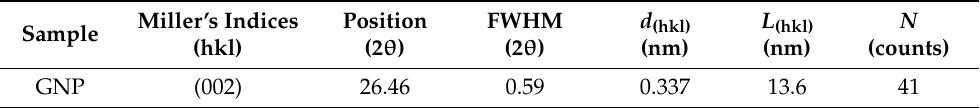
Table 1. Structural parameters obtained from the (002) peak in the XRD patterns of the GNP on LDPE substrate. 2 θ is the diffraction angle, FWHM is the full width at half maximum, d (hkl) is the average distance of graphene layers, L (hkl) is the average height of the crystallites obtained from the FWHM, and N is the average number of graphene layers of a nanoplatelet.